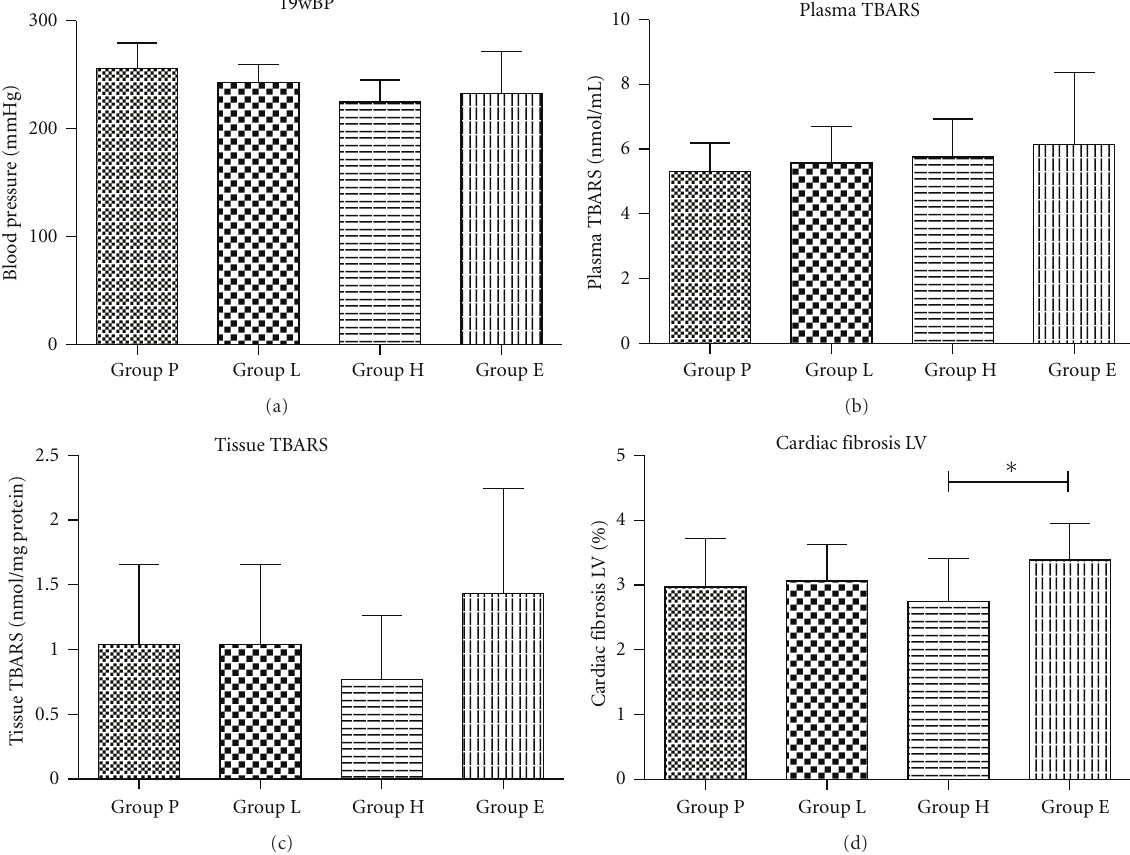
Figure 1: The mean blood pressure (mmHg), plasma TBARS (nmol/mL), tissue TBARS (nmol/mg protein), and cardiac fibrosis in LV (%) after ACEI administration. Cardiac fibrosis in LV was decreased in Group H and increased in Group E, so that there was a significant di ff erence between Group H and Group E. Table 1: Echocardiographic data in 19 weeks. Detailed data from the echocardiographic studies. No statistically significant di ff erence was observed among the ACEI administration groups in IVSd, IVSs, LVPWd, and %FS. IVSs (mm) LVIDs (mm) LVPWs